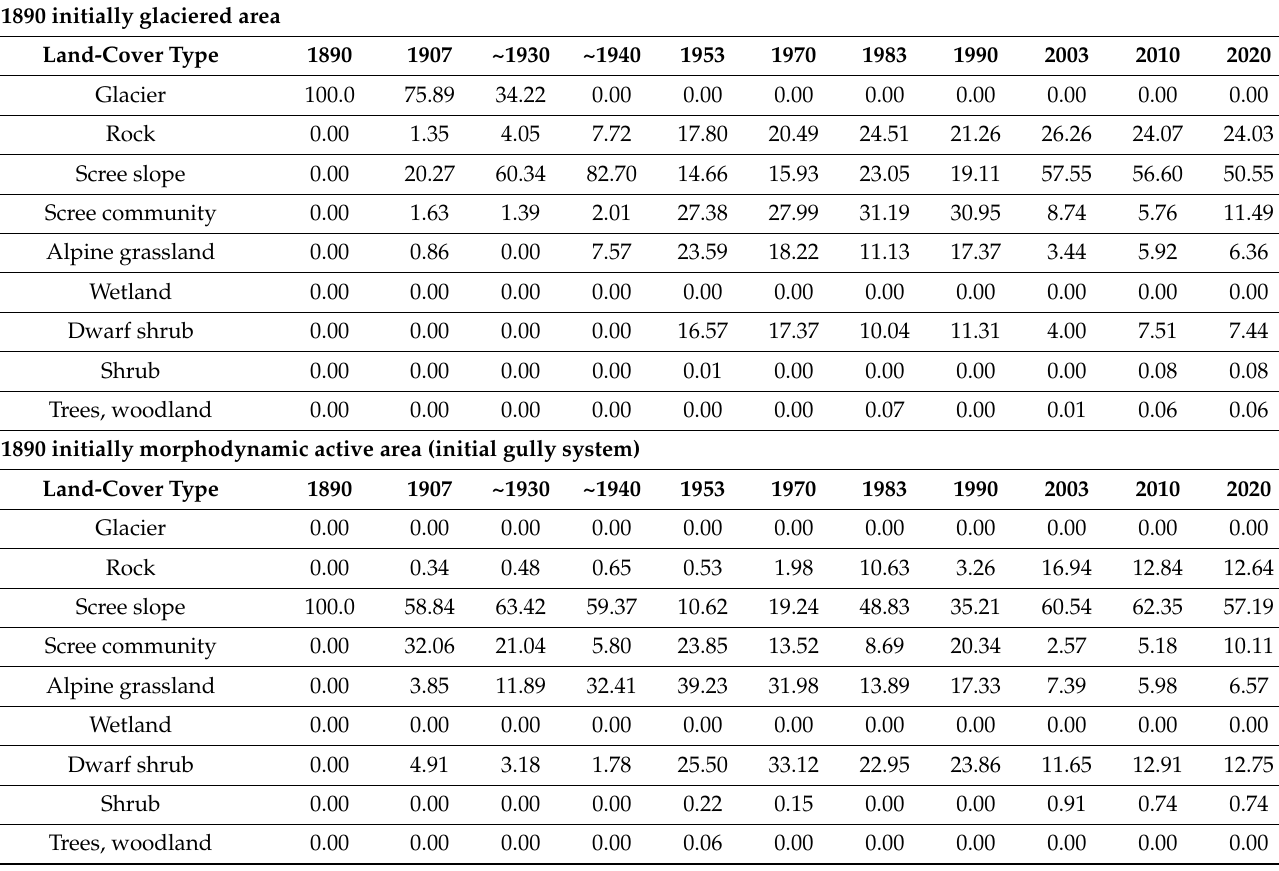
Table A8. Changes of land-cover types from End of LIA to 2020 with the proportion [%], on the